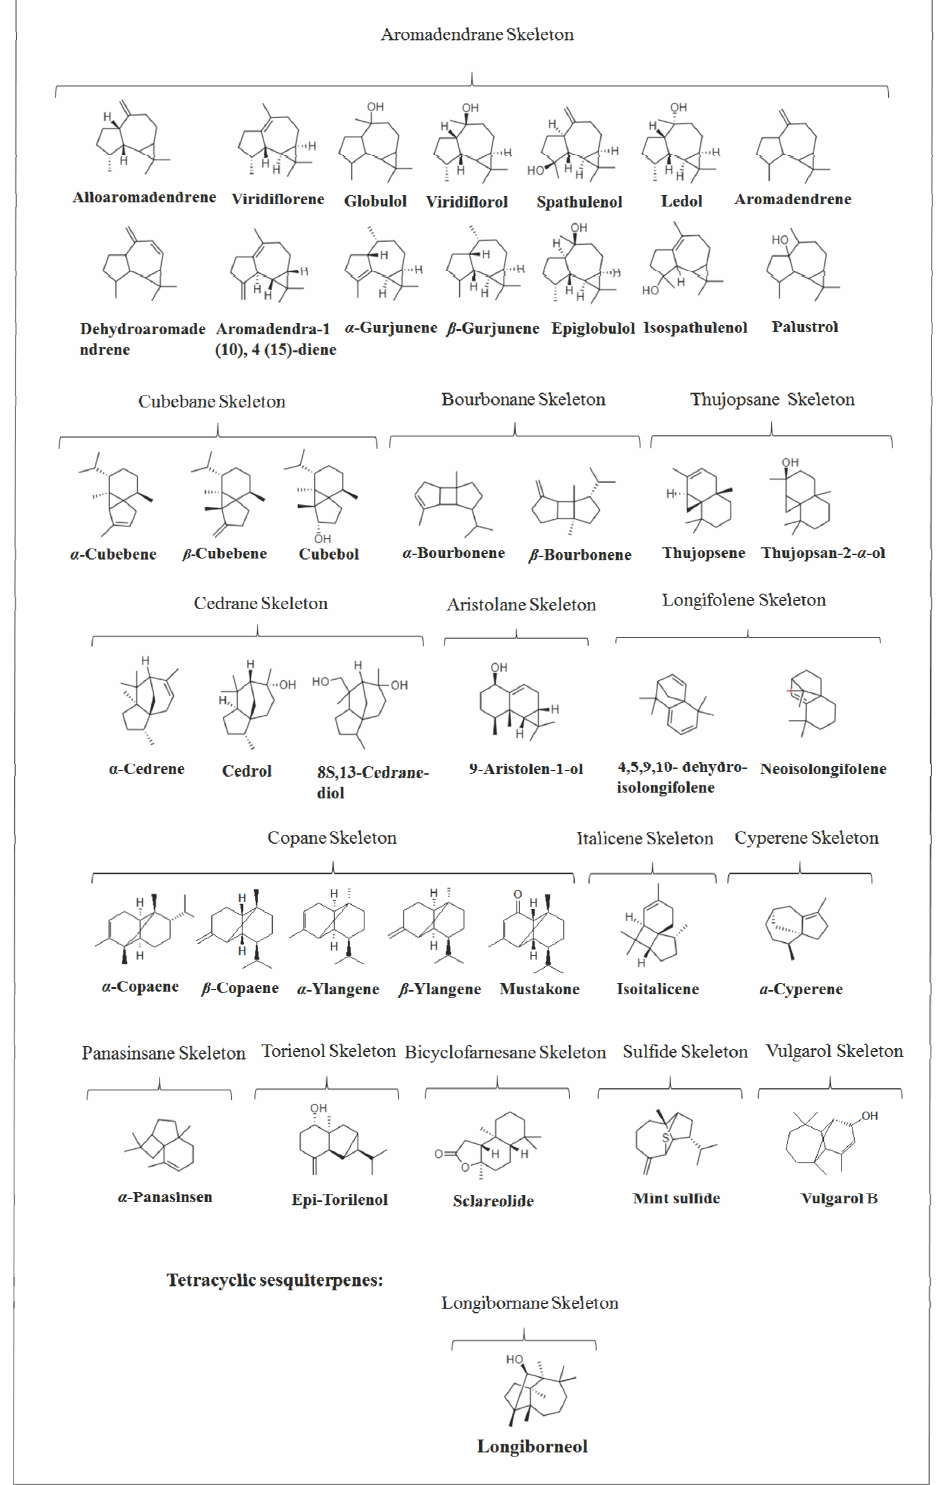
Figure 13. Structure of tricyclic and tetracyclic sesquiterpenes in Vitex species.